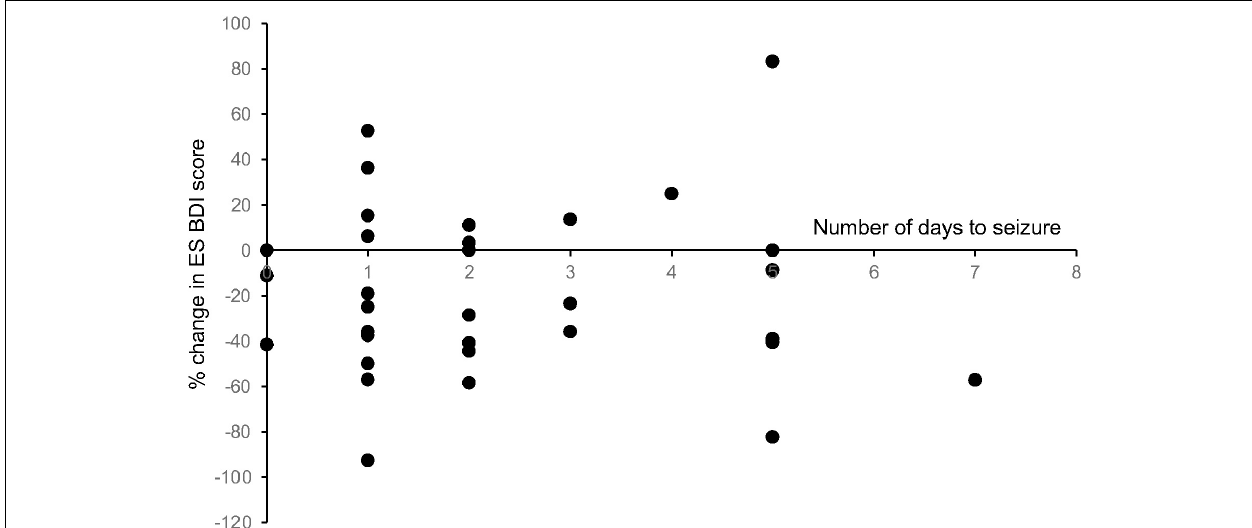
FIGURE 6 | Length of stay in the EMU compared with change in mood scores. To determine whether the length of stay in the EMU had any effect on the change in mood scores, we performed a linear regression analysis of the number of days admitted to the EMU prior to the first seizure event versus the change in mood score. This correlation was found to be non-significant across all mood measures for patients with both ES and NES (R2 values: ES BDI = 0.0002, ES BAI = 0.025, ES MADRS = 0.083, NES BDI = 0.030, NES BAI = 0.0029, NES MADRS =